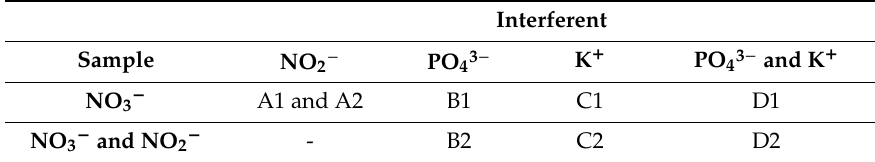
Table 3. Series of tests performed toward analysis of interferences, in a sample of nitrate and a sample of nitrate and nitrite.